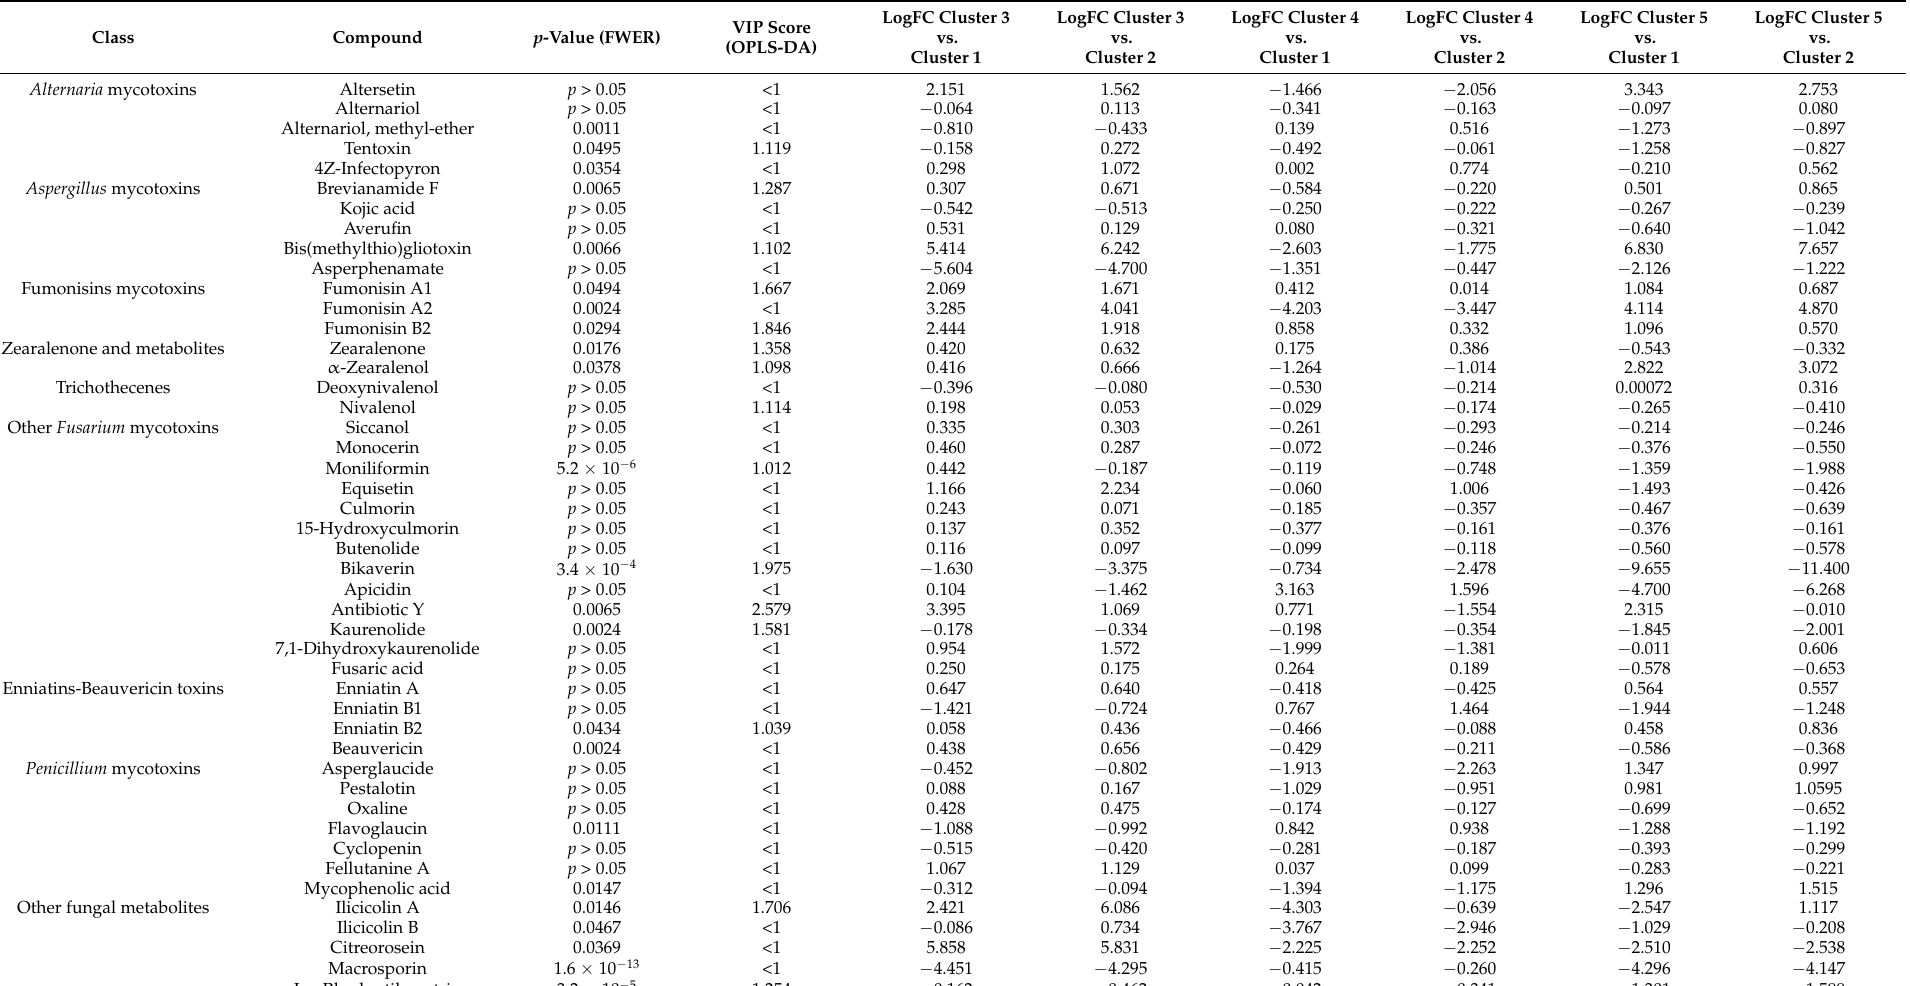
Table 1. Mycotoxins detected by HRMS in the different milk samples. Each compound is provided with its VIP score (from OPLS-DA), log2 fold-change (FC) value and p-value (FWER) resulting from the volcano plot